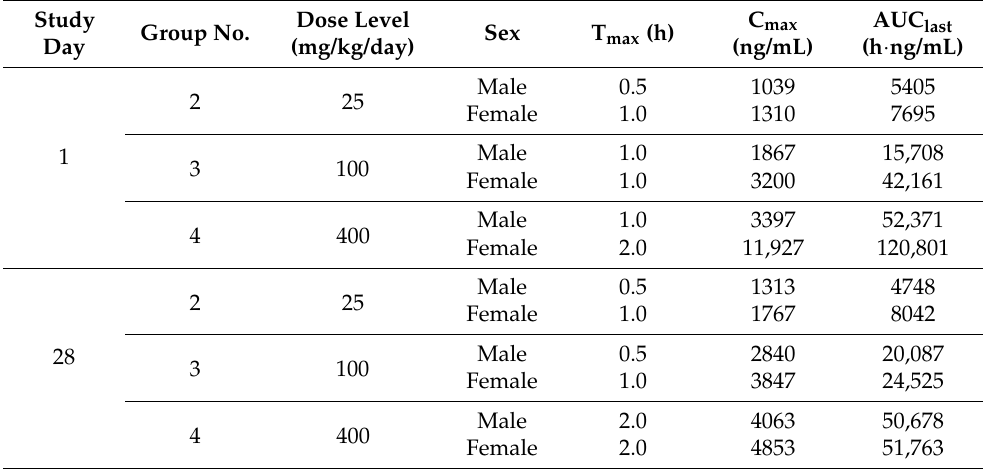
Table 3. ZB716 28-day repeated-dose TK parameters in rat plasma.